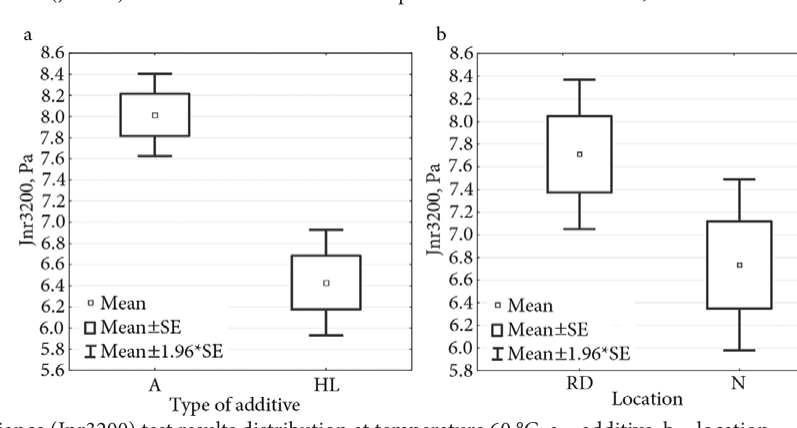
Fig. 10. Creep compliance (Jnr100) test results distribution at temperature 60 °C: a – additive; b – location